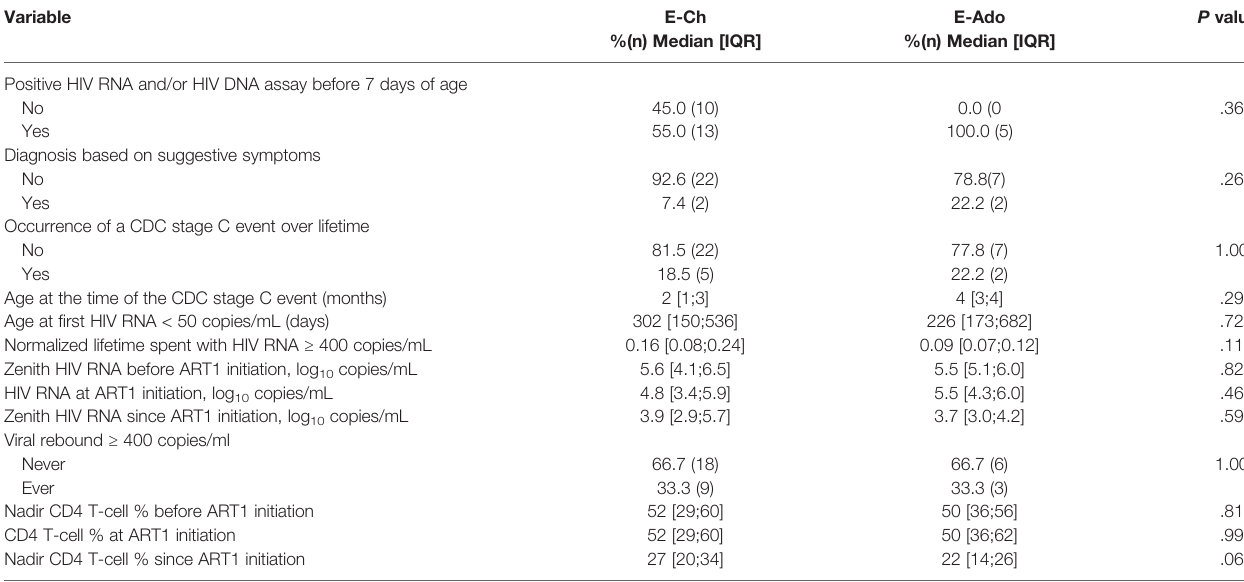
TABLE 2 | HIV history variables in E-Ch and